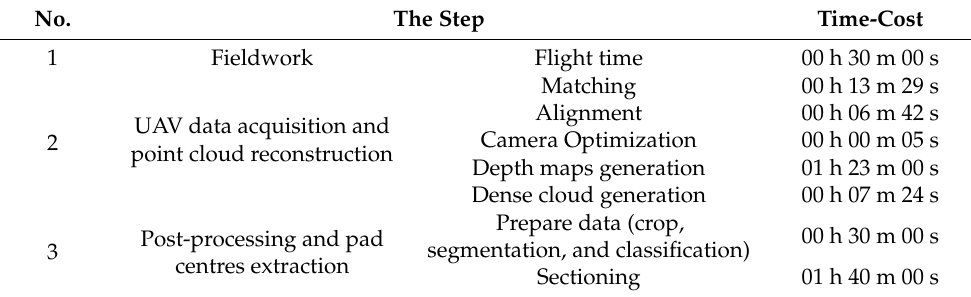
Table 1. Time-cost breakdown for the proposed